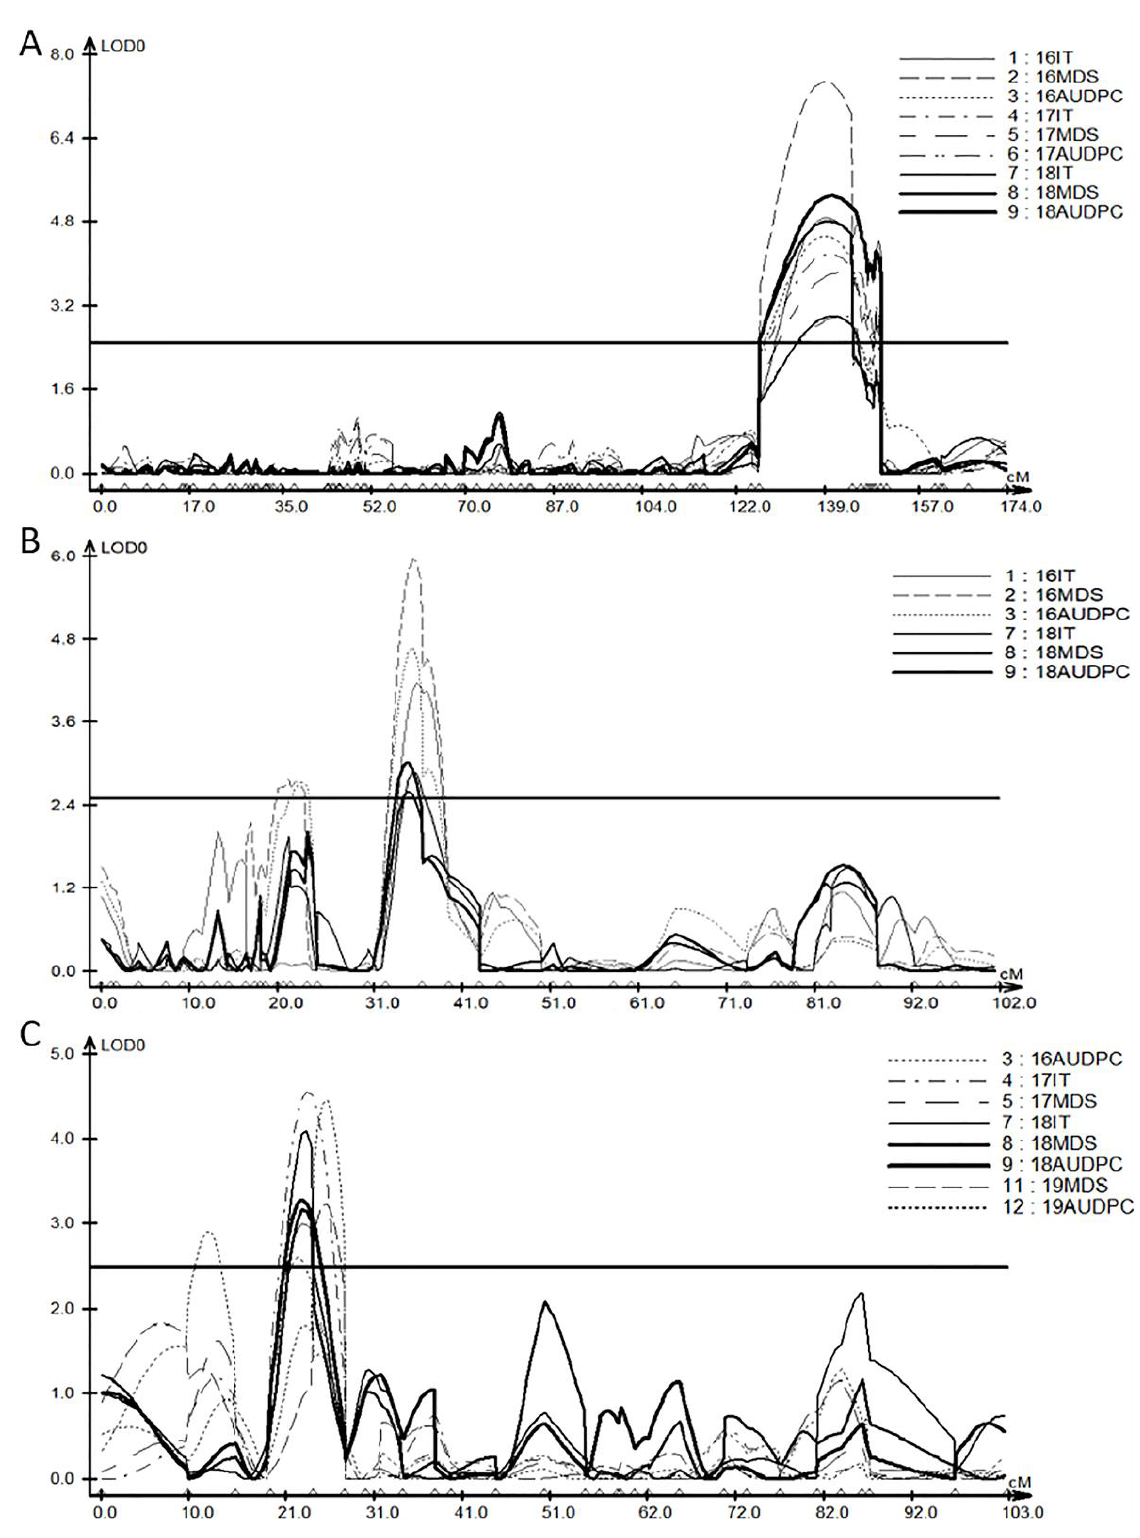
Figure 3. Composite interval mapping (CIM) of QTLs for stripe rust adult-plant resistance on chromosomes 1B ( A ), 5B ( B ), and 6B ( C ), using phenotypic data collected from the four experiments from 2016 to 2019. The line parallel to the X -axis is the threshold line for the significant LOD score of 2.5. Genetic distances are shown in centiMorgans (cM). IT = infection type; MDS = maximum disease severity; AUDPC = area under the disease progress curve. Table 2. Name, position, LOD score, phenotypic variation explained (PVE), and additive effects of quantitative trait loci (QTLs) for stripe-rust resistance at the adult stage in a population of Tutoumai x Siyang 936 identified using composite interval mapping (CIM) and the phenotypic data collected from the experiments conducted from 2016 to 2019. QTL